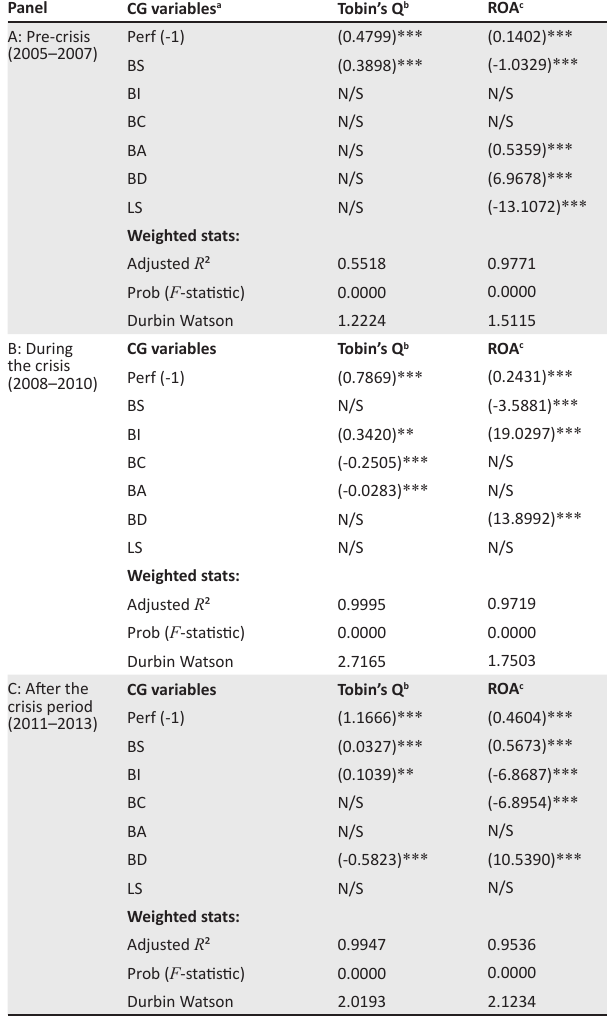
Note: Table 6 shows regression results of the impact of corporate governance attributes on Tobin’s Q and ROA for the basic material industry. The abbreviations and definitions of the independent and control variables presented in this table are contained in Table 1. Panel A is for the pre-crisis period (2005–2007), Panel B is for the crisis period (2008–2010) and